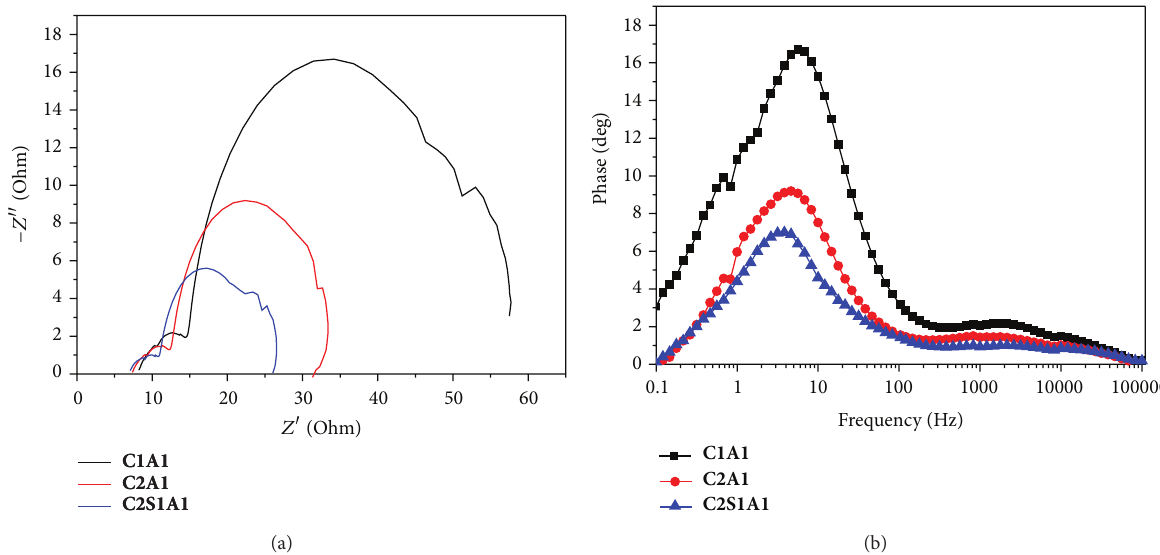
Figure 4: (a) Measured dye-sensitized solar cell impedance spectrum at forward bias condition under illumination. (b) Bode-phase plots for the dye-sensitized solar cells.